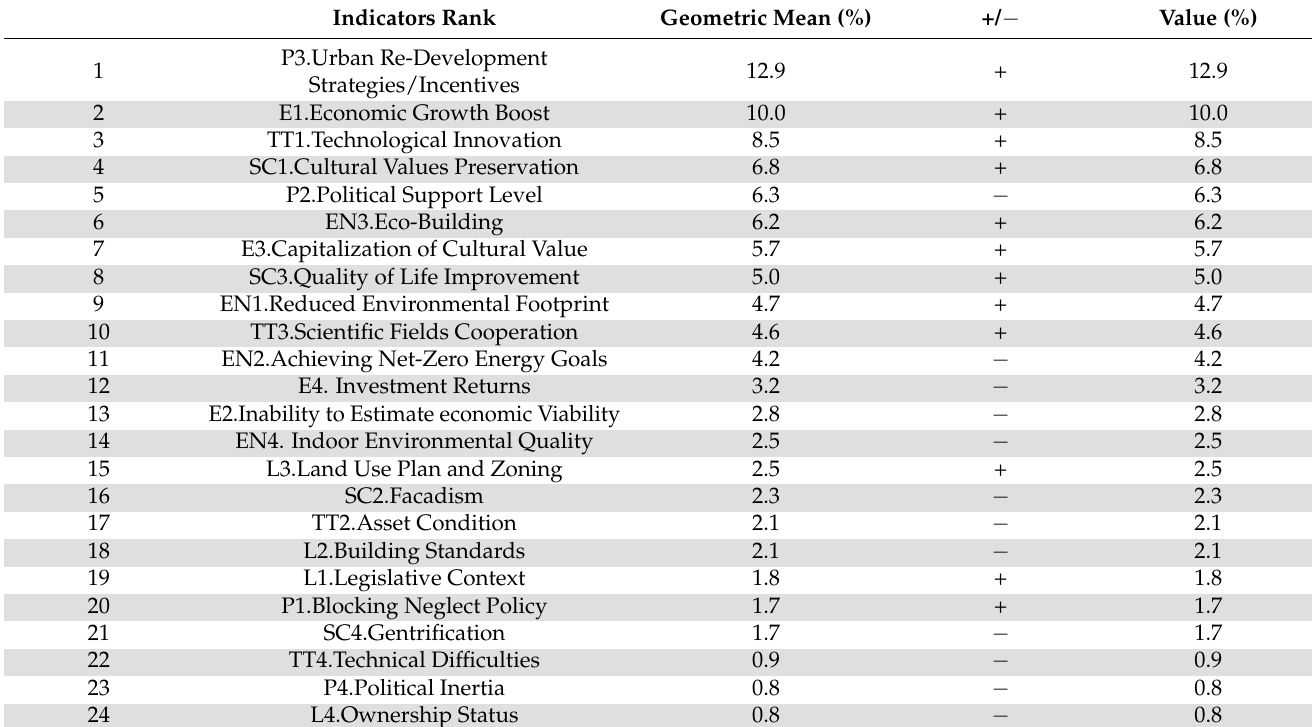
Table 7. Indicator of final